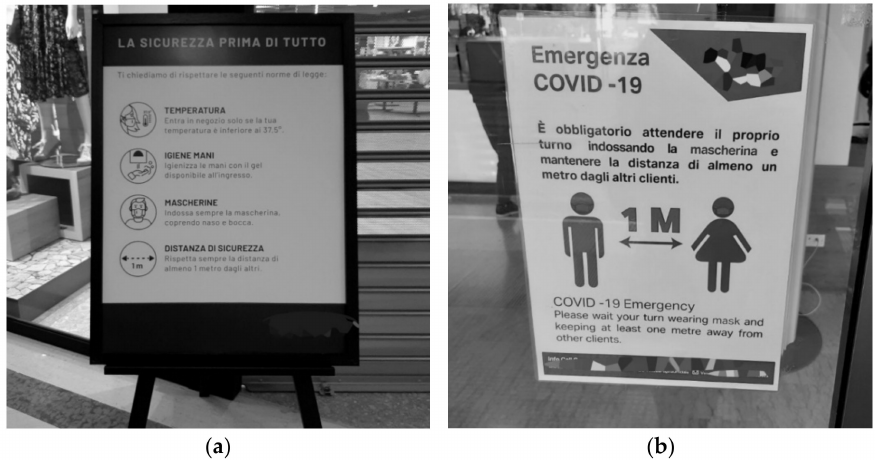
Figure A4. Images illustrating examples of informative vertical signage (E1) ( a ) and of vertical signage with spatial recommendations (E2) ( b